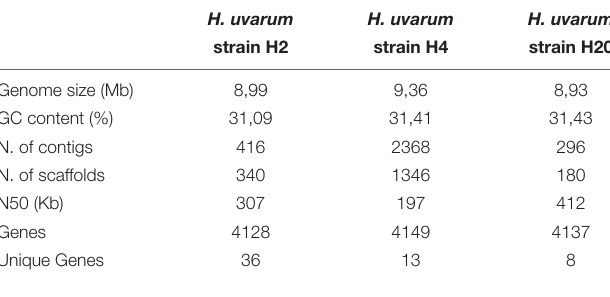
TABLE 3 | Summary of genome assembly for H2, H4, and H20 H. uvarum